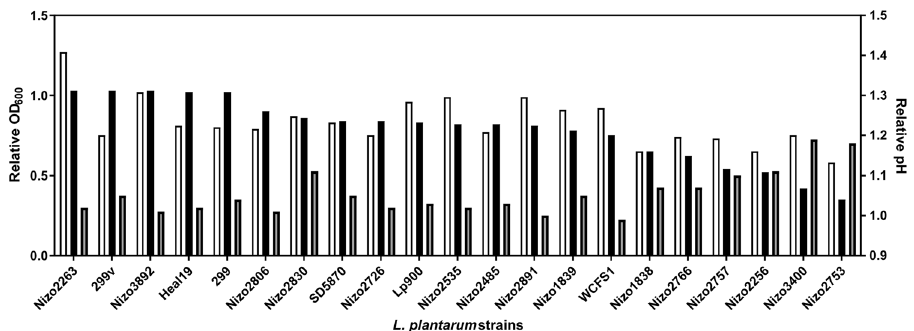
Figure 1. L. plantarum strain-specific relative growth on GOS. The relative growth (OD 600 ) after 24 h of L. plantarum strains on ½ MRS-C supplemented with 0.5% GOS in comparison to their growth on ½ MRS-C supplemented with 0.5% glucose in batch growth experiments (OD 600 ; black bars, n = 1) and pH (grey bars, n = 1) and its congruency with the relative optical density (OD 600 ; white bars, n = 3) obtained in a previous reported in vitro screening 16